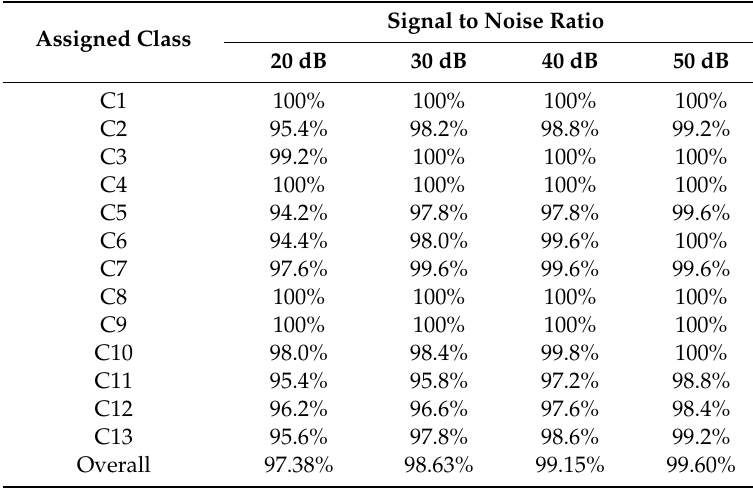
Table 4. Performance of PQD classification accuracy under a noisy environment.